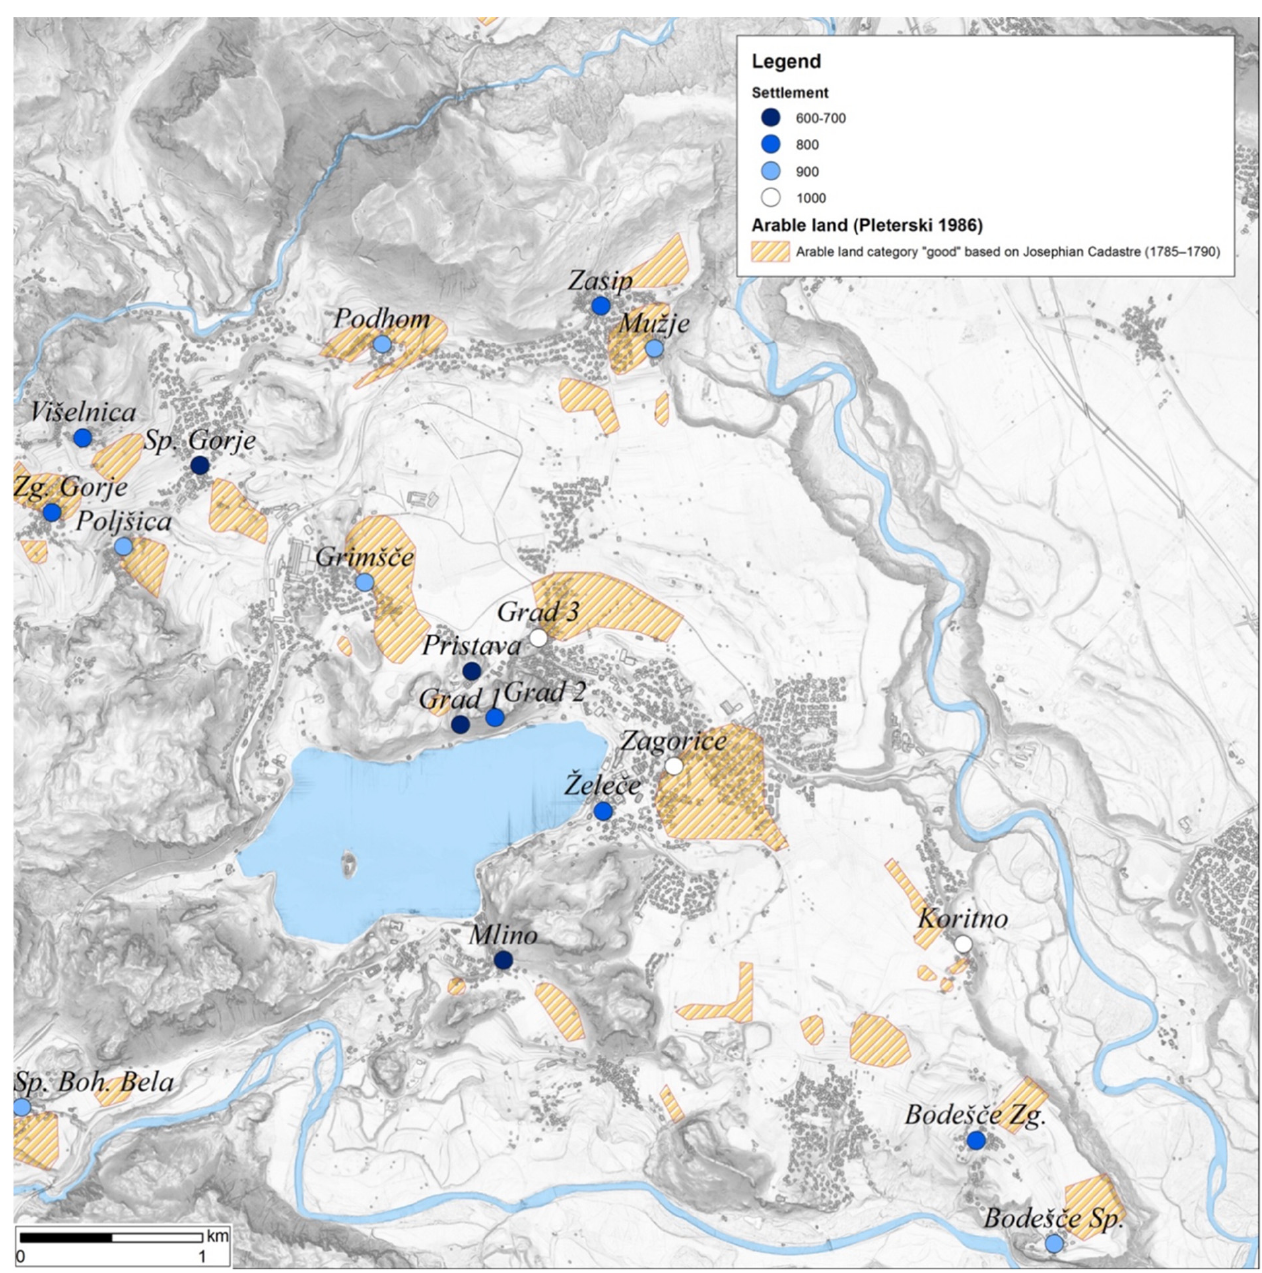
Figure A1. Bled microregion (decimal longitude and latitude coordinates of the map centre: 14.1139; 46.3752), early medieval settlements (letters refer to Table 2 in the text), and arable land category “good” based on the retrograde analysis of the 19th century Franciscan Cadastre (source data adopted from [37]; North at the top).